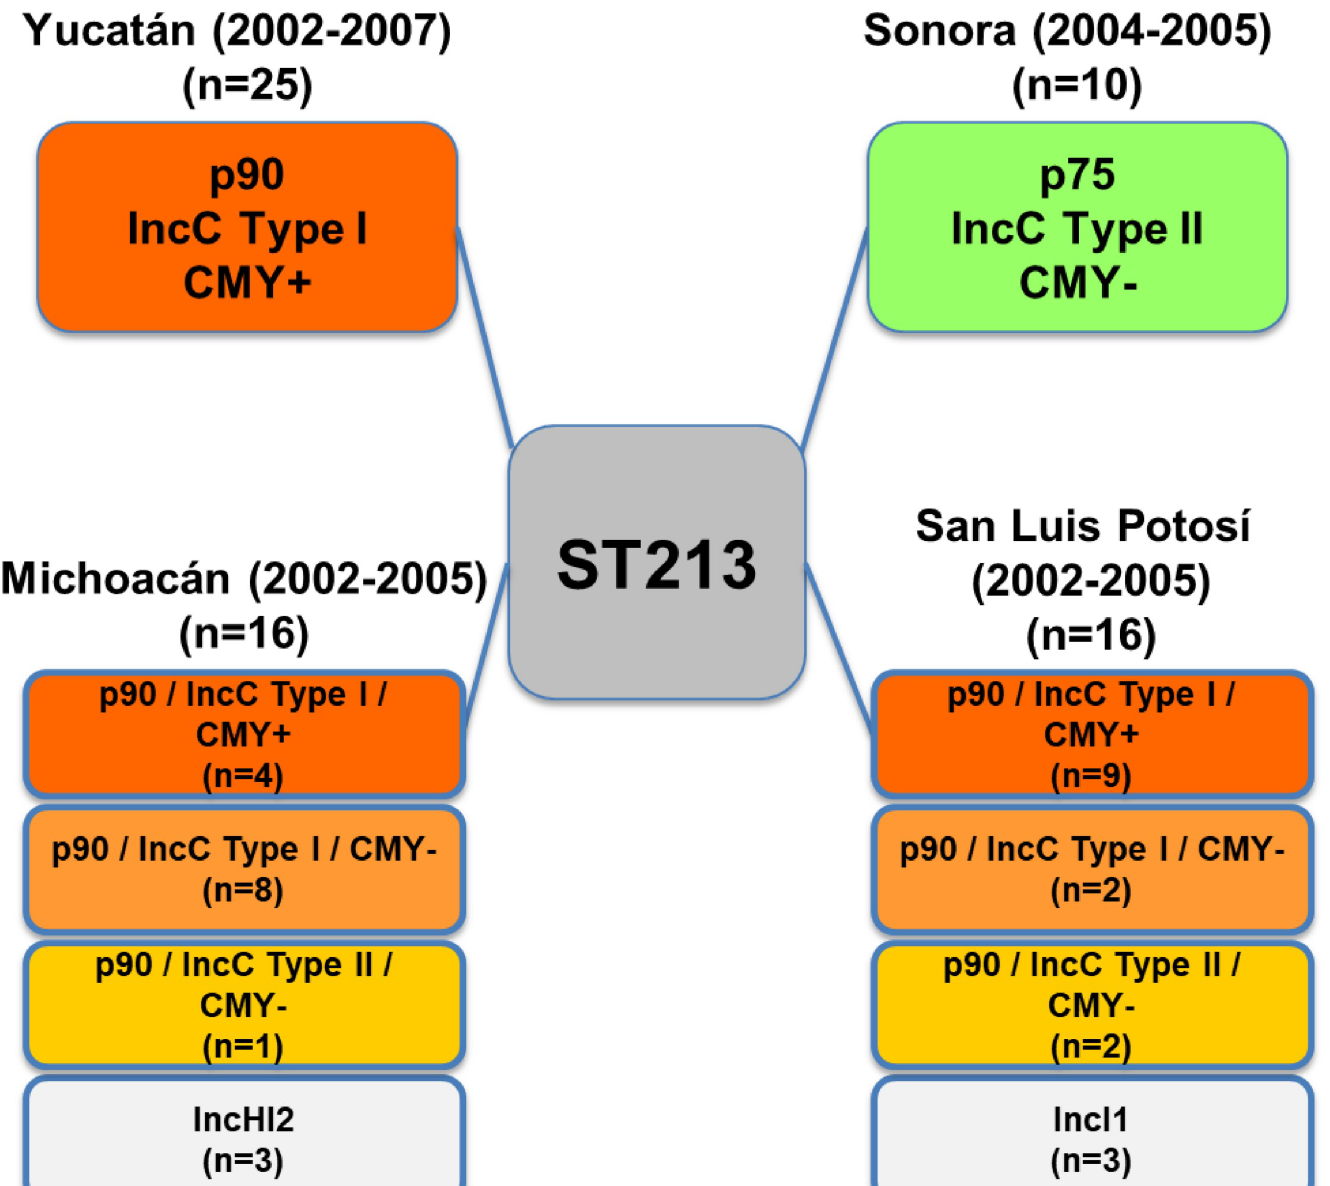
Fig 5. Schematic representation of the presence of IncC and D6-like plasmids in Typhimurium ST213 strains according to the isolation geographic location. The isolation date and number of isolates (n) are shown in parenthesis. See Table 1 and text for details.